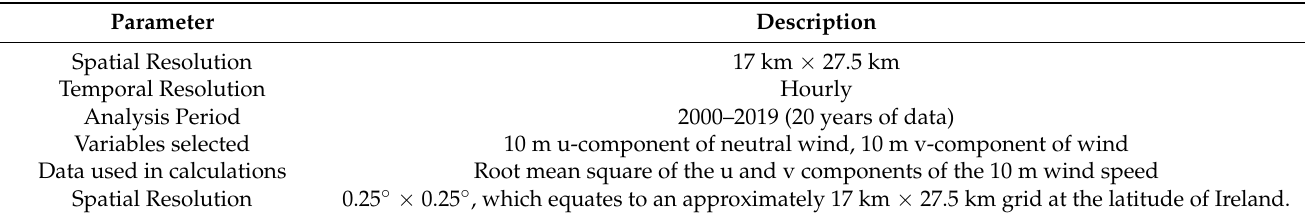
Table 2. Details of wind data downloaded.